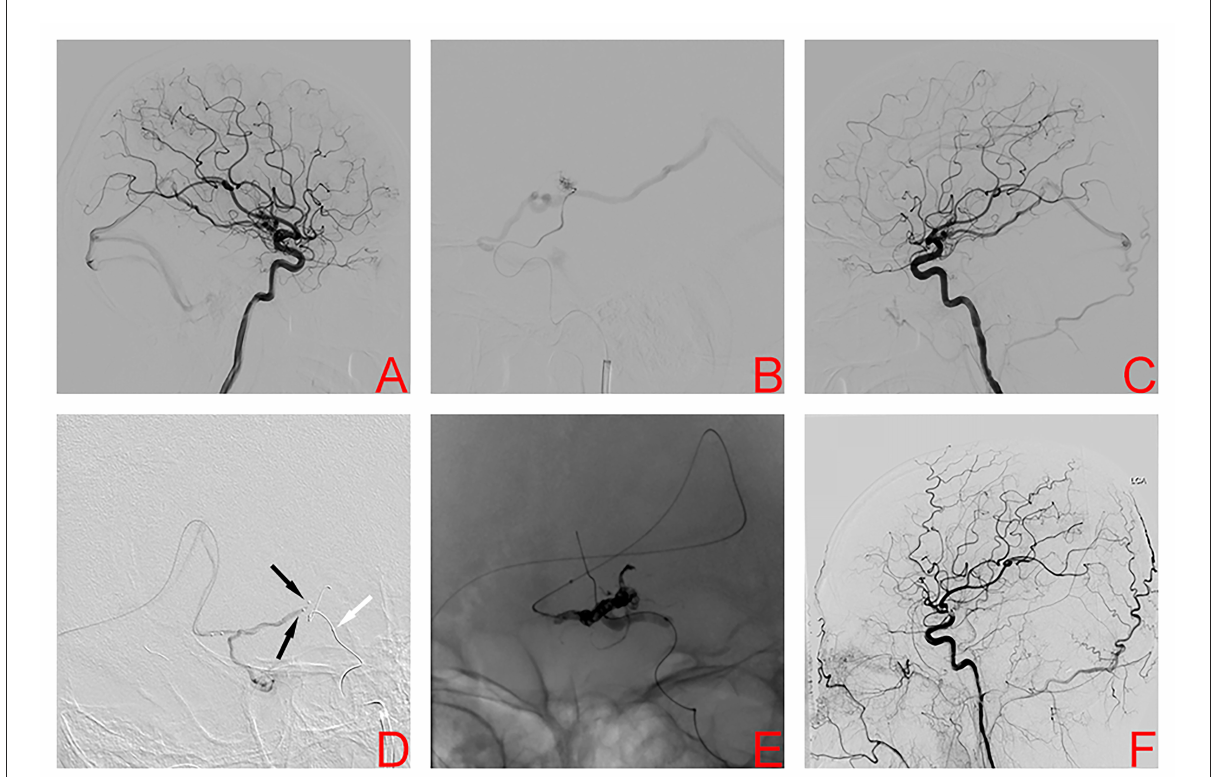
FIGURE1 Digital subtraction angiography left internal carotid artery (ICA) demonstrated the left basal ganglia arteriovenous malformation in case 1 (A) . Superselective arteriography and embolization via the anterior choroidal artery (B) . Immediate angiography of left ICA after transarterial embolization showed a residual small nidus (C) . TVE was performed due to the lack of optimal arterial access. Dual microcatheters (black arrows) were positioned in the origin of the venous collector and a balloon microcatheter (white arrow) was placed in the ipsilateral internal carotid artery (D) . After the balloon was inflated to provisionally occlude the internal carotid artery, we used the PCT to occlude the nidus (E) . Digital subtraction angiography 4 months later confirmed AVM obliteration (F)